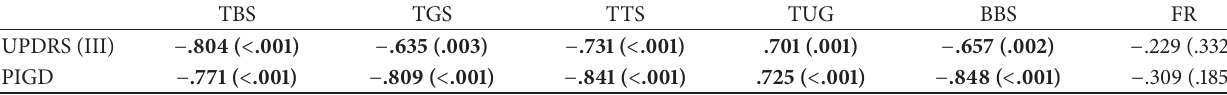
Table 2: Correlations between UPDRS motor score, PIGD, and balance and gait tests.